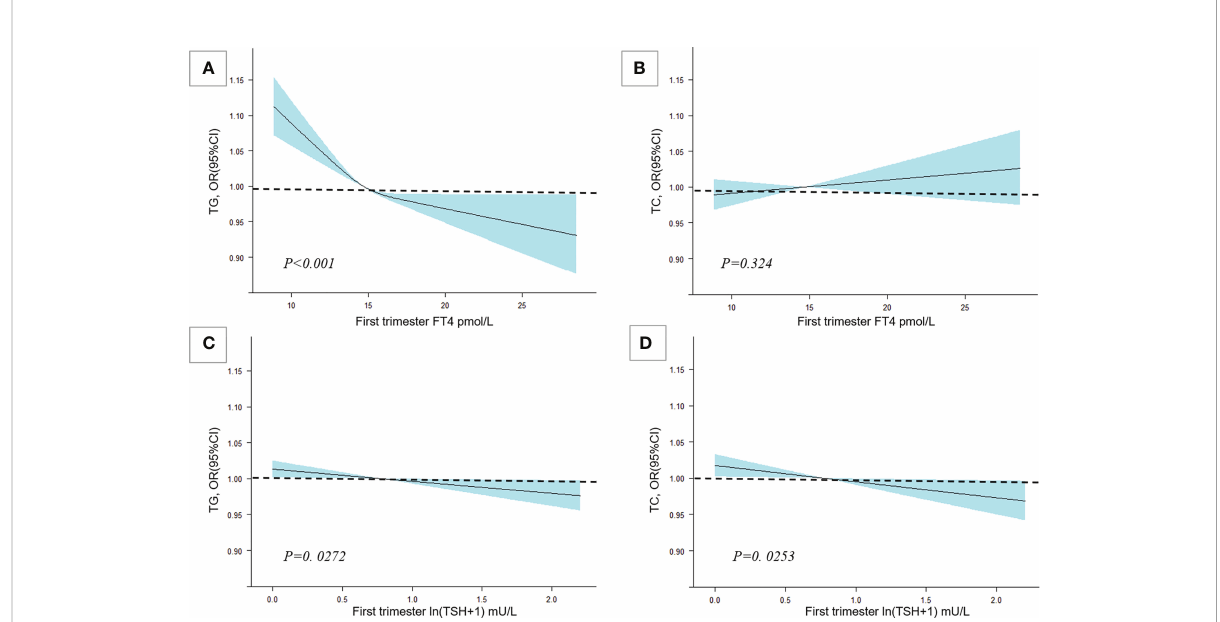
FIGURE 4 The association among TC, TG and maternal thyroid hormone levels. Cubic spline regression analysis of TG and FT4 levels with thyroid hormone levels. Multivariable RCS models were adjusted for maternal age, education level, family history of diabetes, parity, TPOAb status, and prepregnancy BMI. (A) The association between FT4 and TG. (B) The association between FT4 and TC. (C) The association between ln(TSH+1) and TG. (D) The association between ln(TSH+1) and